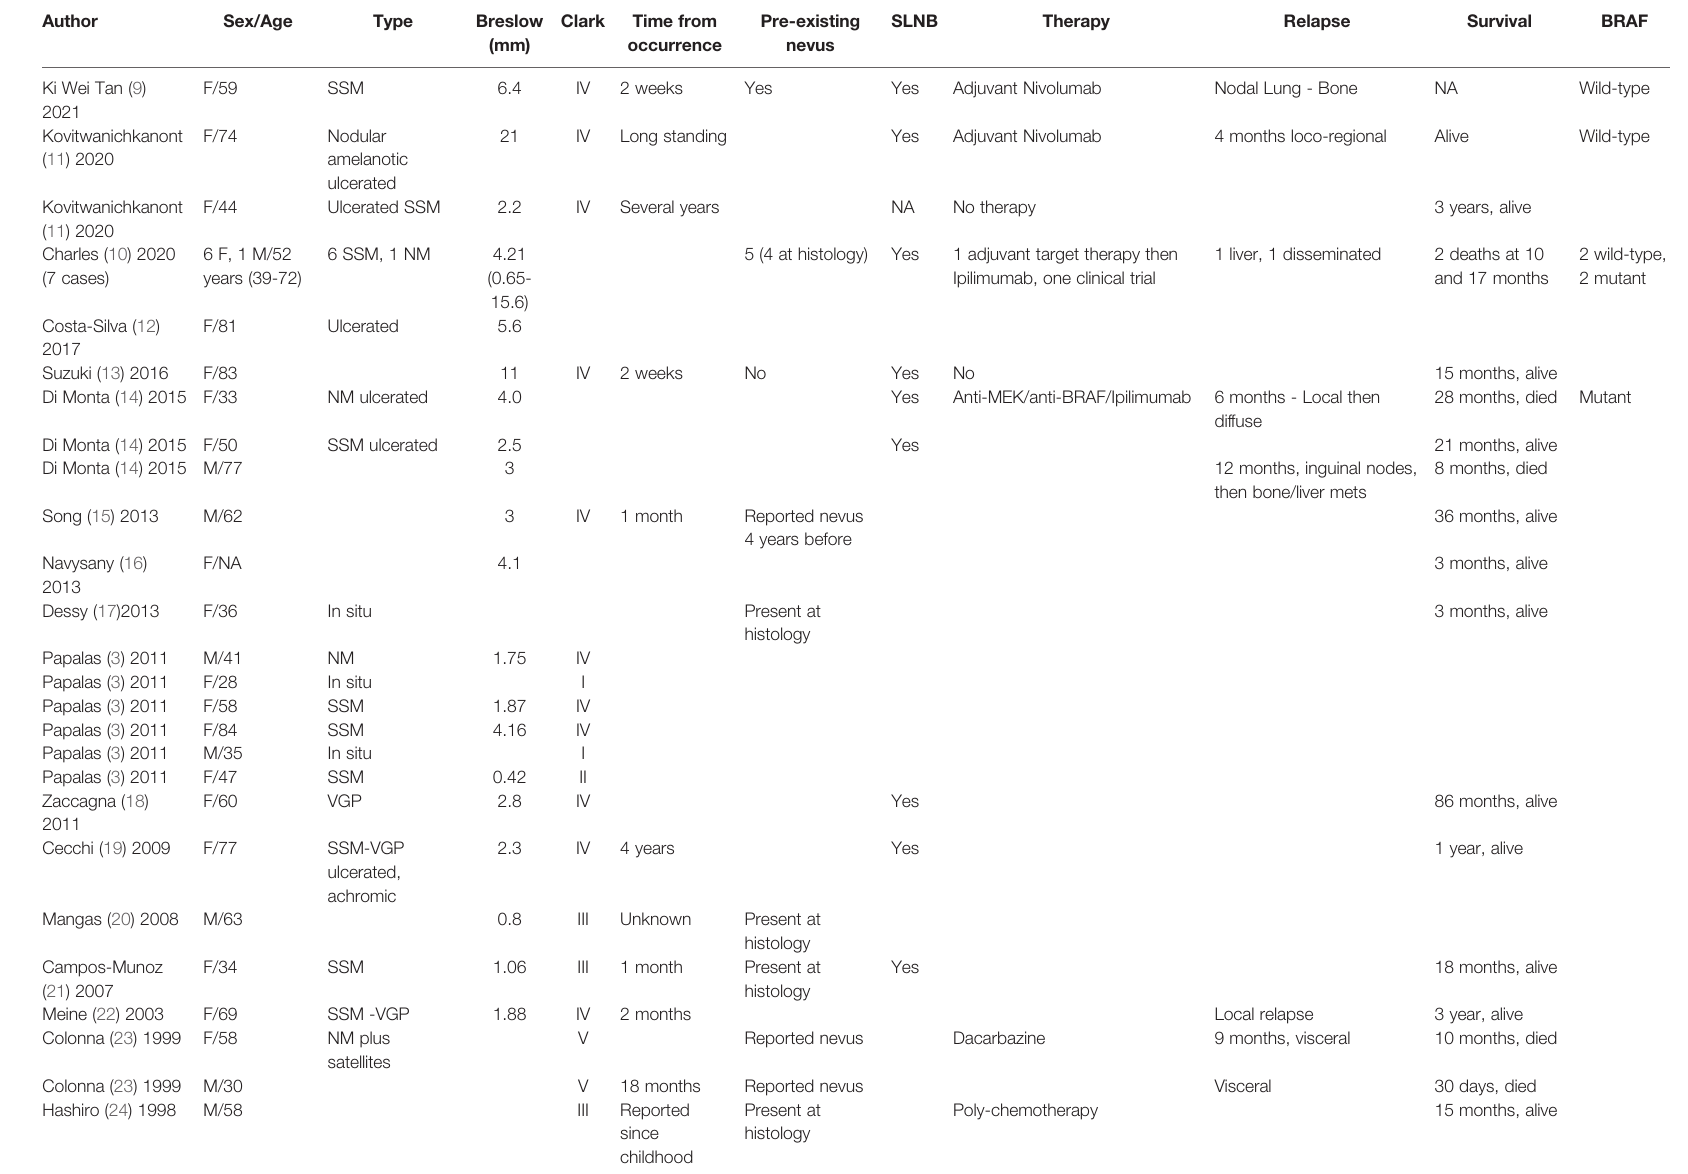
TABLE 1 | Summary of literature fi ndings on umbilical melanoma.